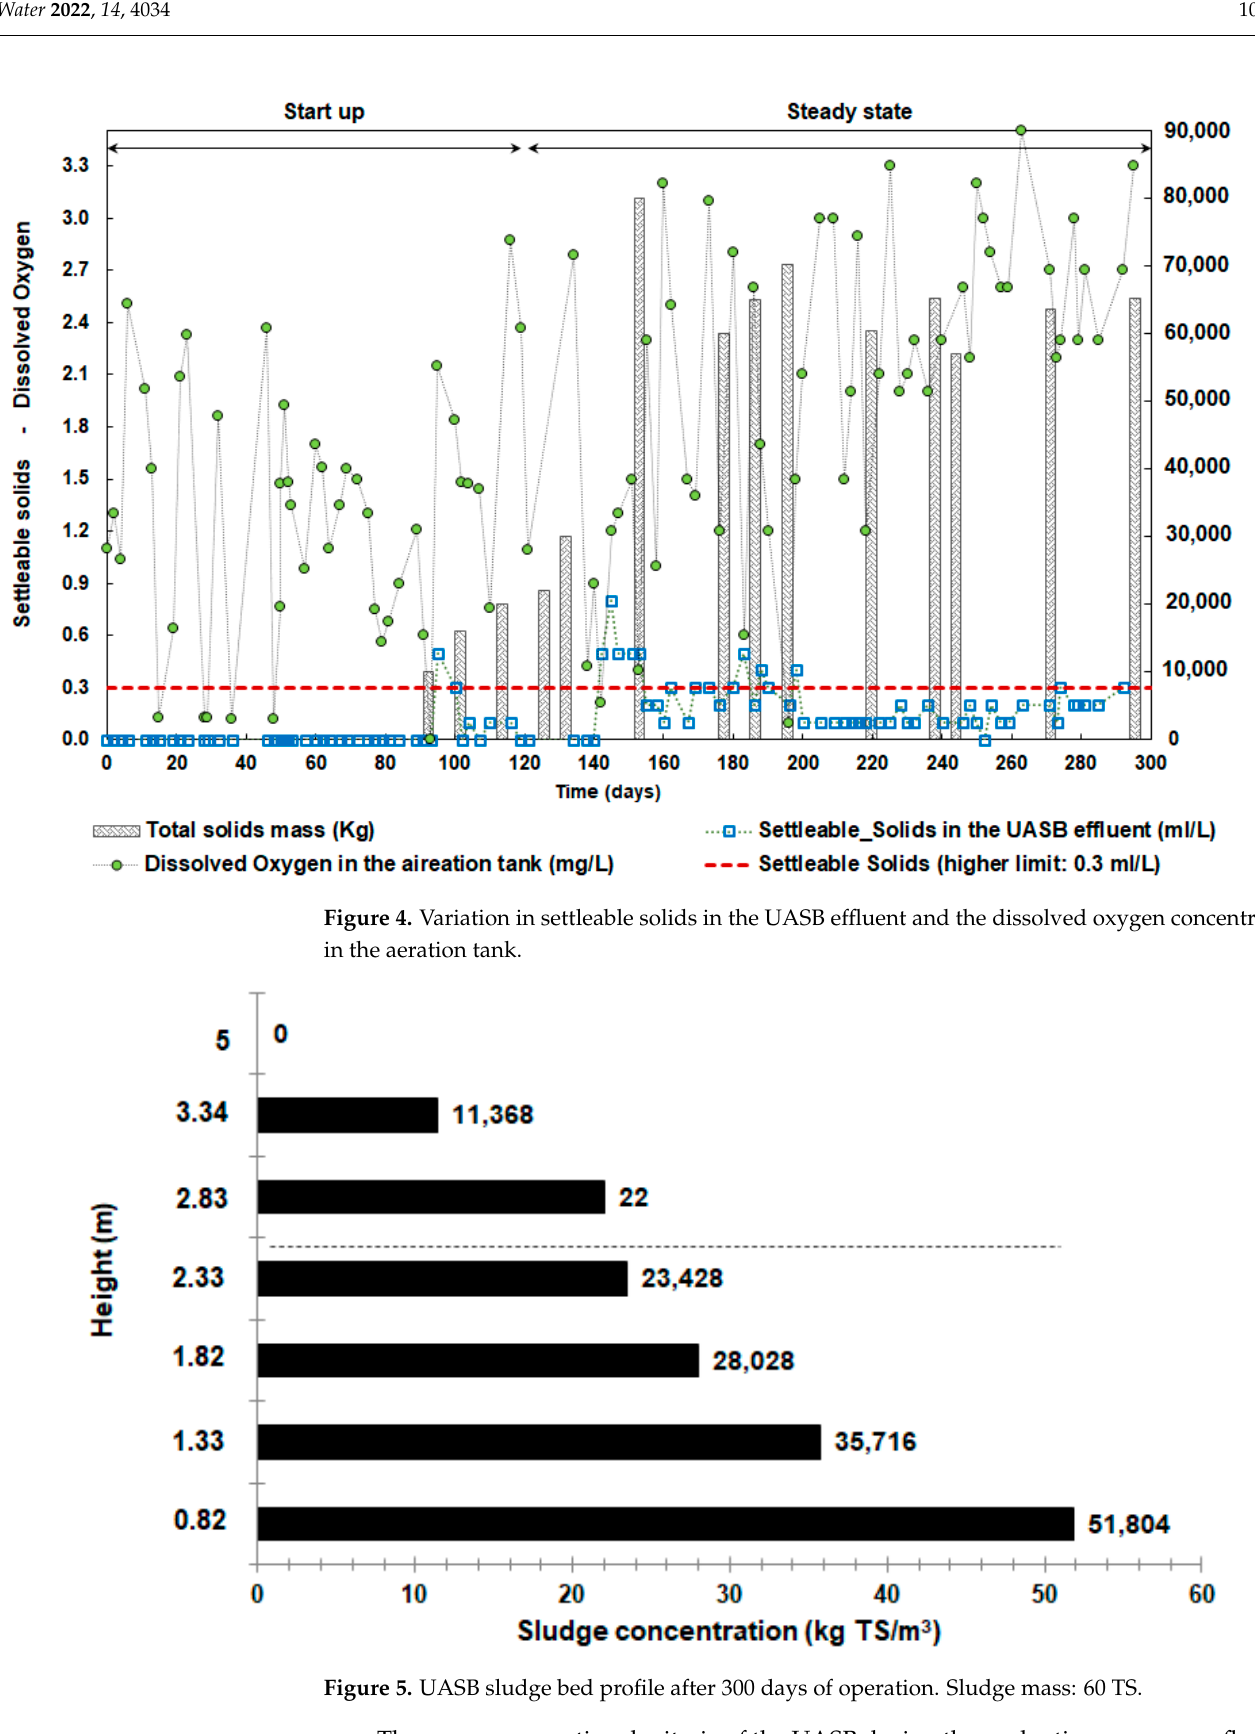
Figure 5. UASB sludge bed profile after 300 days of operation. Sludge mass: 60